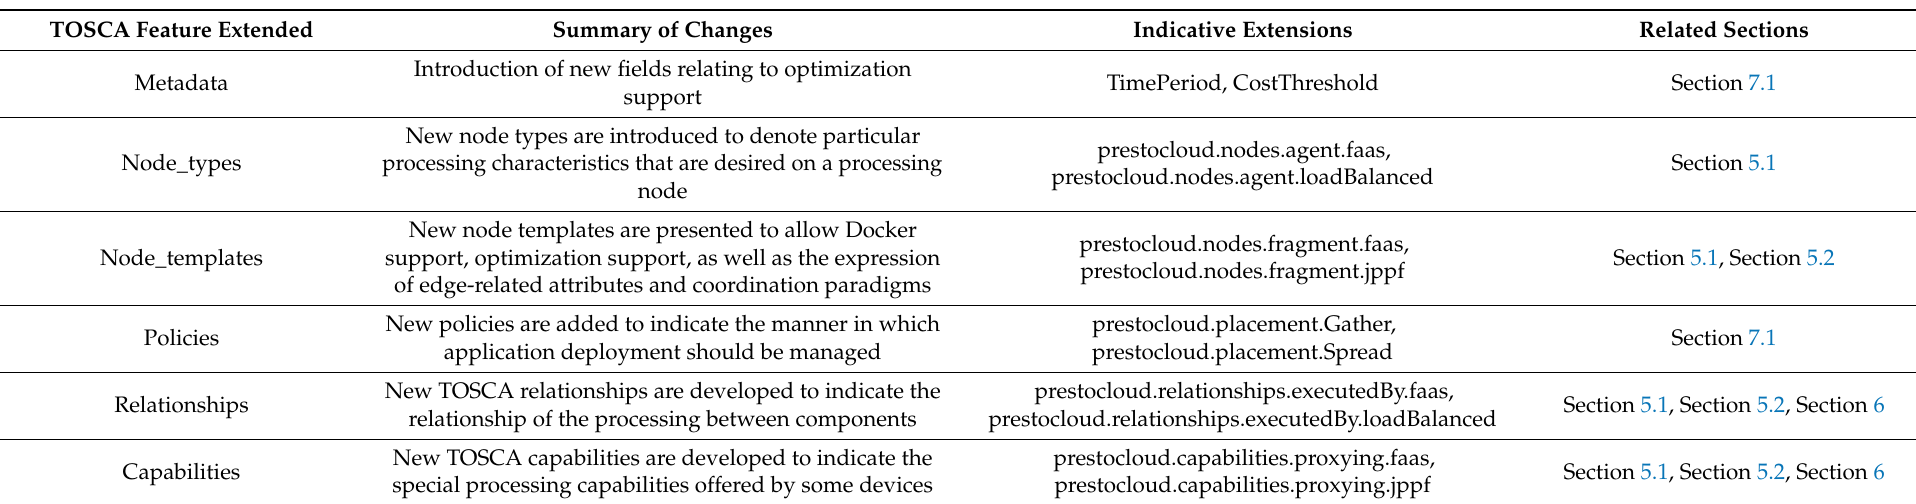
Table 5. Overview of the extensions to core TOSCA